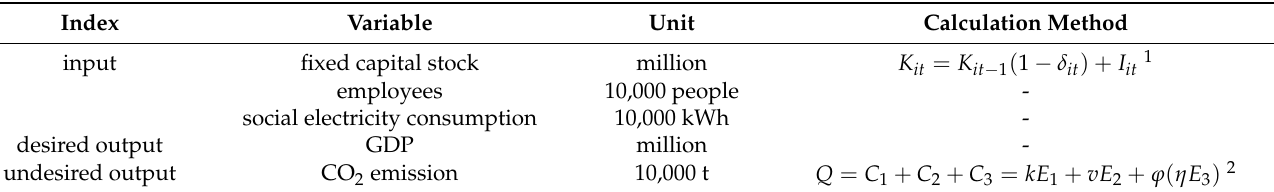
Table 1. Input–output index system of carbon emission